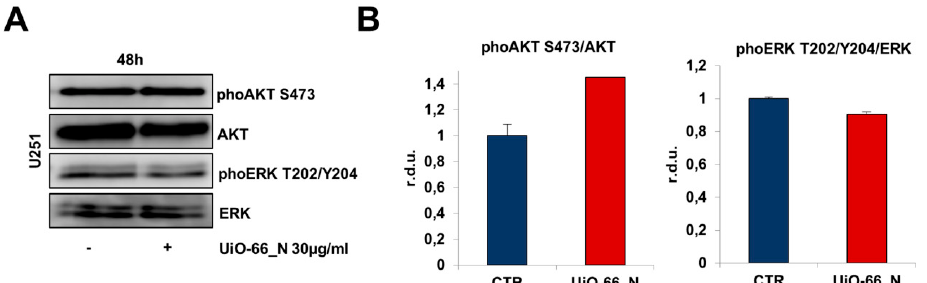
Figure 8. UiO-66_N do not affect Akt and ERK1/2 phosphorylation in U251 glioblastoma cells. Western blots ( A ) and densitometric quantification of Akt and ERK1/2 phosphorylation levels ( B ). The cells were treated with 30 µ g/mL UiO-66_N for 48 h. Blots are representative of at least three experiments. The difference in phoAkt level is not statistically significant.